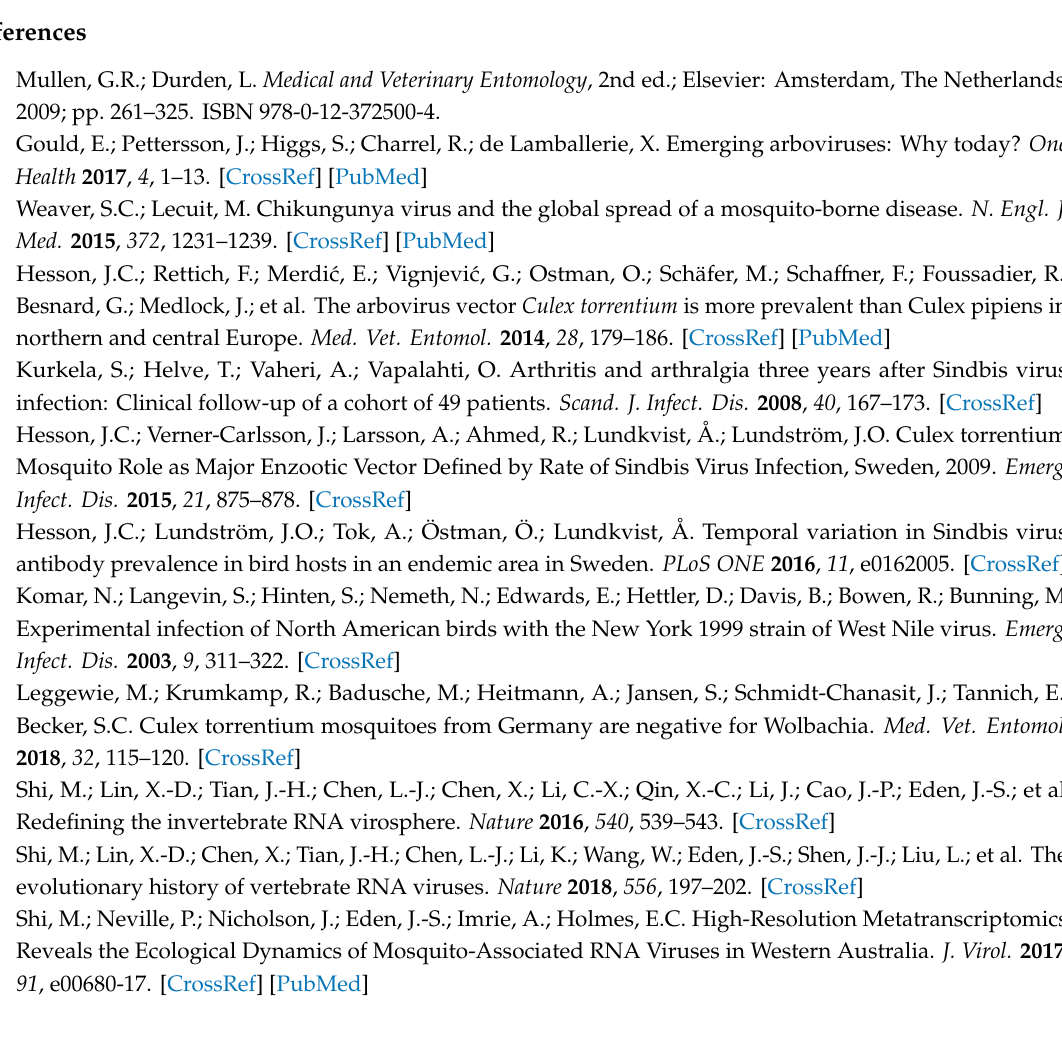
Table S1: Information on collection site, year of collection and pool size for all Cx. pipiens and Cx. torrentium libraries; Table S2: Number of reads mapped to each virus, Wolbachia and host genes per library per mosquito species. Author Contributions: Conceptualization, J.H.O.P., E.C.H., and J.C.H; formal analysis, J.H.O.P., M.S., and